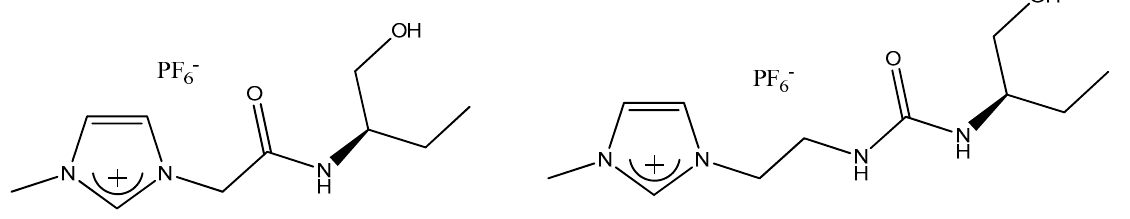
Figure 6. Chemical formulas of imidazolium-based ( R )-CILs(adapted from Wu, 2015) [157].